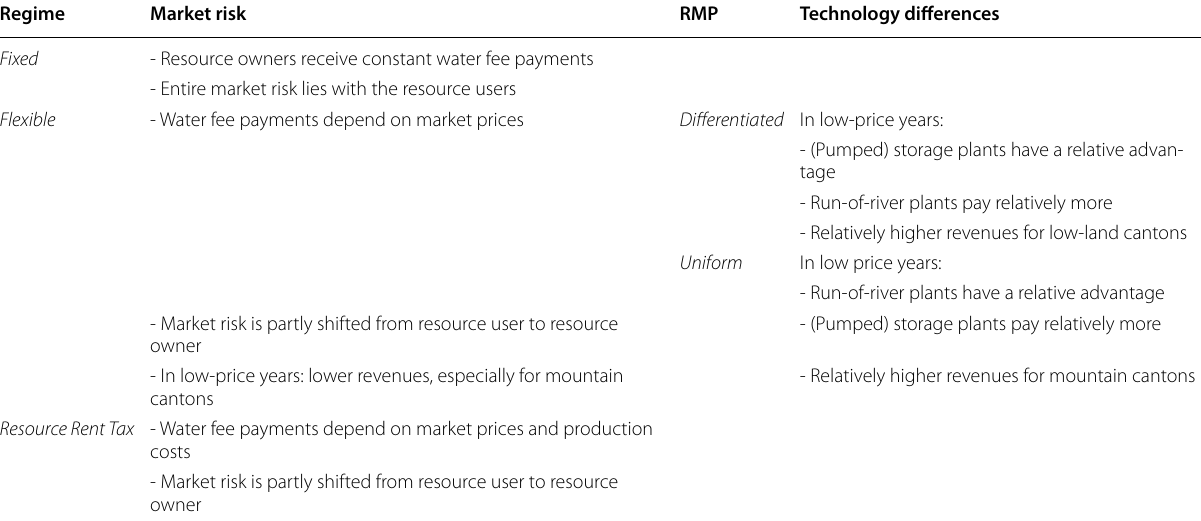
Table 5 Risk shift from resource users to resource owners